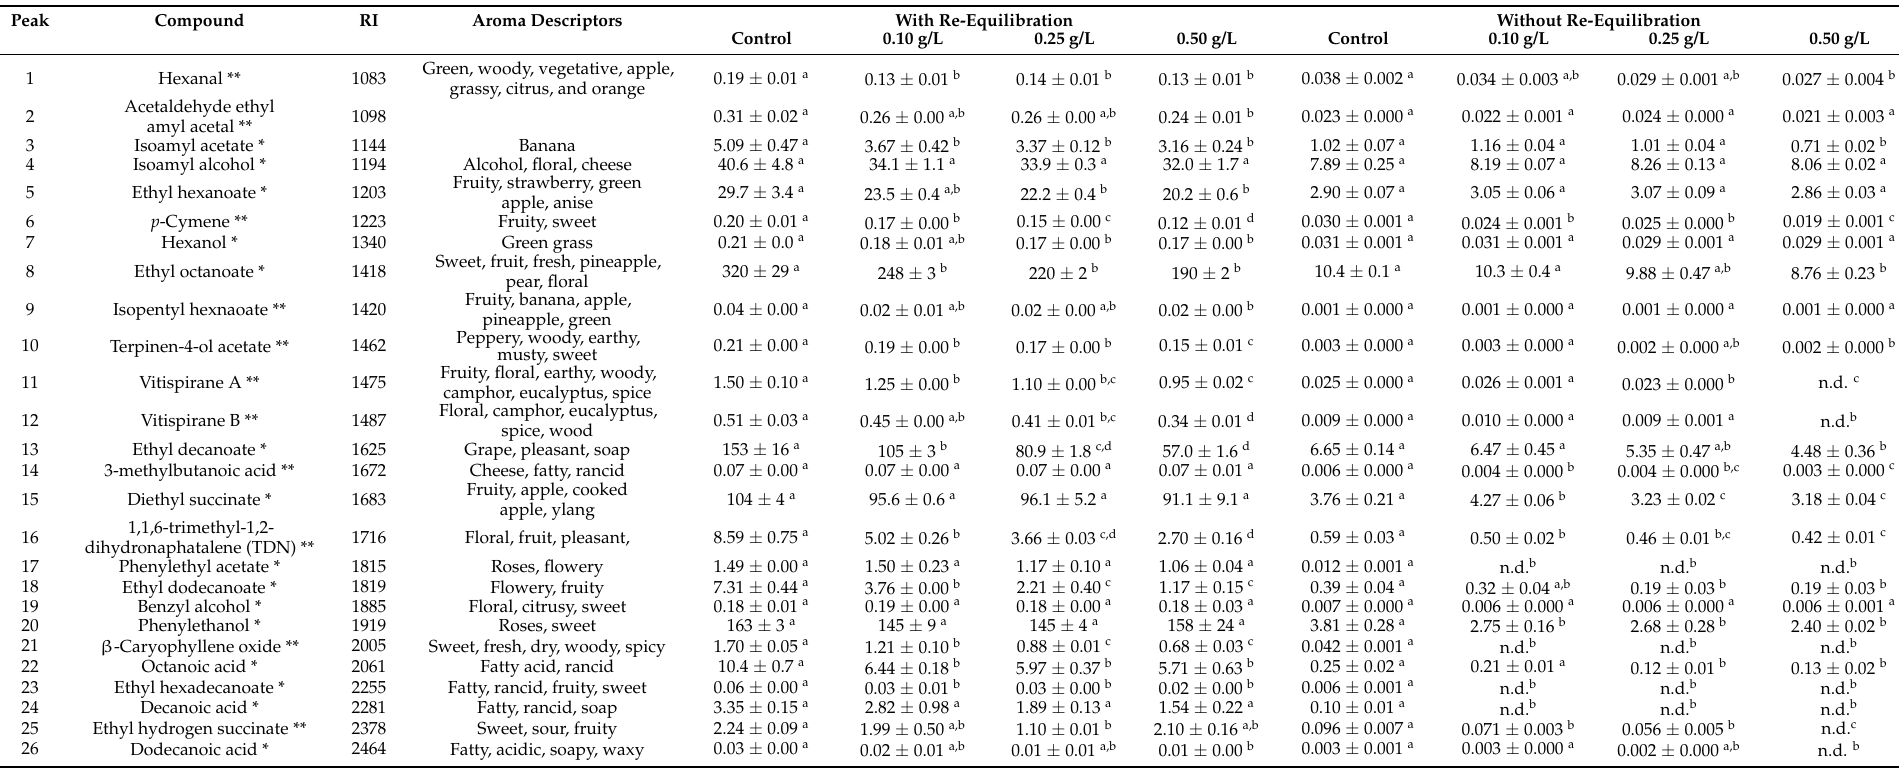
Table 6. Volatile components identified in the red wine headspace by SPME extraction with re-equilibration and without re-equilibration and the effect of ADSI cork powder application dose (0.10, 0.25, and 0.50 g/L) on the volatile abundance (area × 10 5